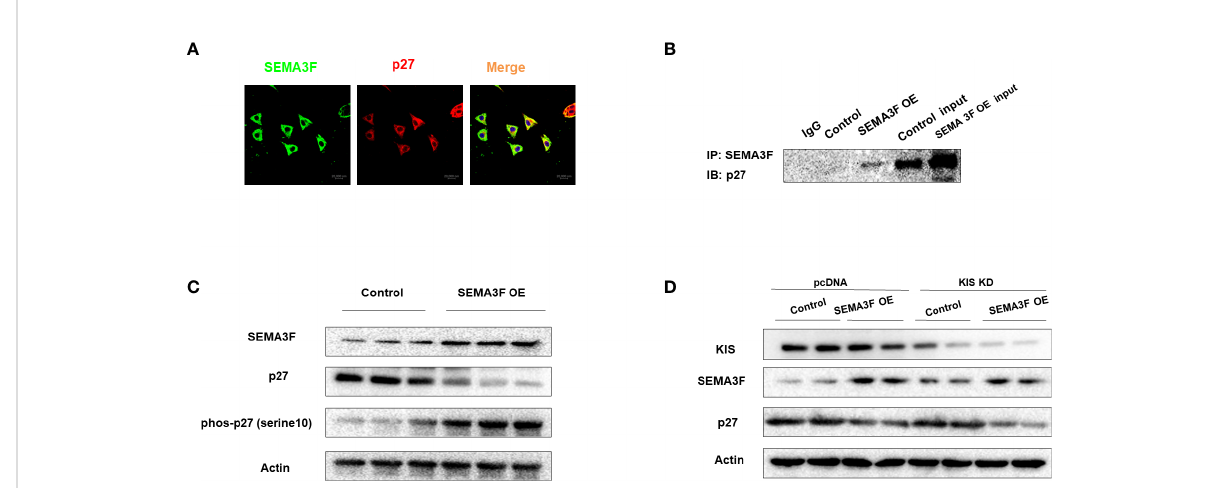
FIGURE 5 SEMA3F promotes p27 degradation by interacting with p27 and inducing its phosphorylation at Ser10. (A) Immuno fl uorescence analysis of SEMA3F (green) and p27 (red) in LoVo cells with SEMA3F OE. (B) The interaction between SEMA3F and p27 was assessed using an immunoprecipitation assay with LoVo cells with SEMA3F OE. (C) p27 and phosphorylated p27 expression levels in LoVo cells with SEMA3F OE and control cells were determined by Western blot analysis. (D) Western blot analysis was used to determine SEMA3F and p27 expression levels in the SEMA3F OE and control groups when the phosphorylation of p27 was or was not